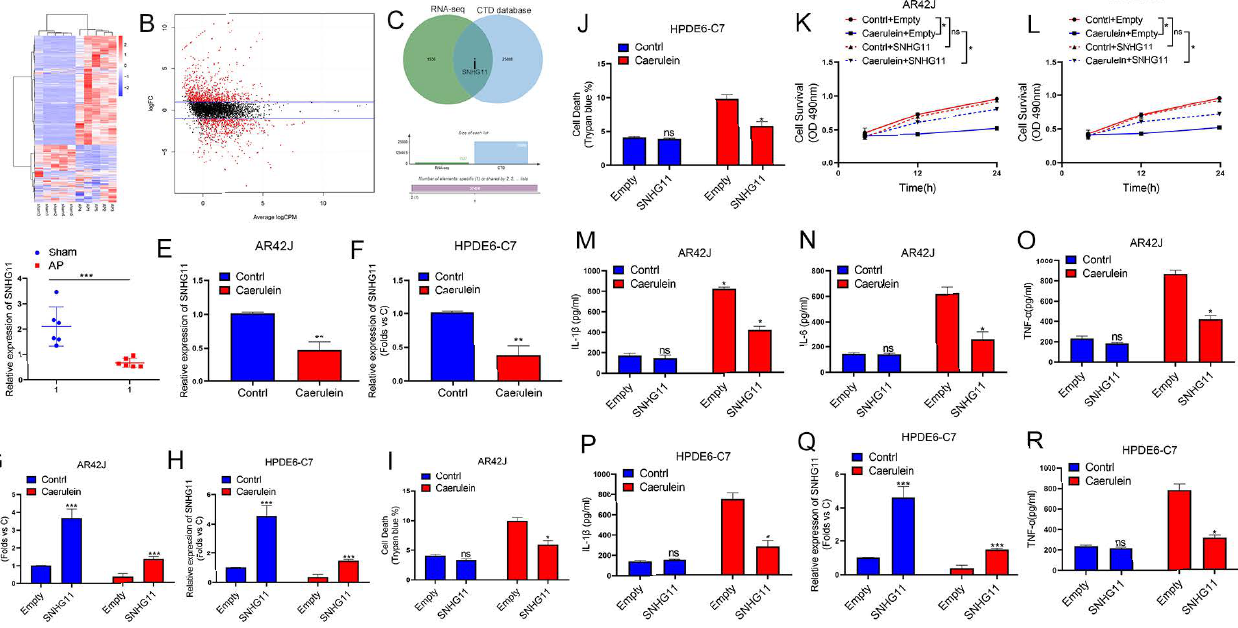
Figure 2. Pancreatitis is accompanied by a decrease in lncRNA-SNHG11. ( A , B ) The matrix ( A ) and volcano ( B ) maps of differential lncRNA obtained by RNA-seq in AP vs. sham. ( C ) The CTD database was used to screen pancreatitis-related genes and intersect with different lncRNAs to find the common gene SNHG11. ( D – F ) Expression of SNHG11 in the rats, AR42J and HPDE6-C7 assessed by qPCR ( n = 3). ( G , H ) The stable overexpression strain of SNHG11 was constructed in AR42J and HPDE6-C7 cells, and the transfection effect was verified by qPCR experiment ( n = 3). ( I , J ) The effect of SNHG11 on cell death induced by caerulein was observed by Trypan blue test in AR42J and HPDE6-C7( n = 3). ( K , L ) Cell proliferation was assessed by CCK8 assay in AR42J and HPDE6-C7 cell lines ( n = 3). ( M – R ). Expression of IL-6, TNF- α , and IL-1 β in the AR42J and HPDE6-C7 cell lines (empty vs. SNHG11) assessed by ELISA ( n = 3). The data are presented as means ± SDs, * p < 0.05; ** p < 0.01; *** p < 0.001, between the indicated groups. ns = no